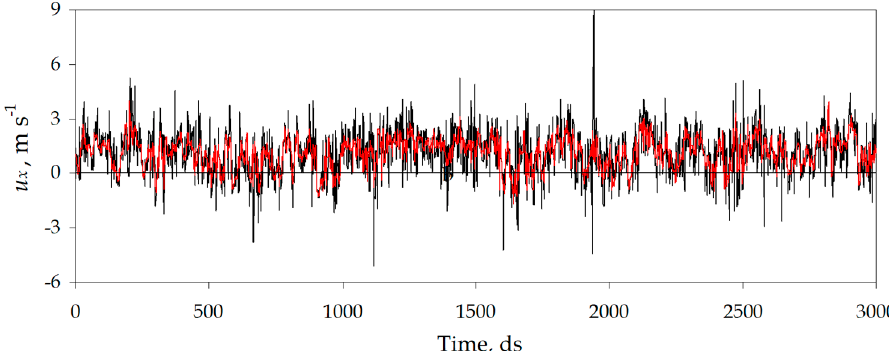
Figure 5. Three-dimensional sonic anemometry u x measurements from Test 1 at the side window windward oriented. Inner side of the IPS at the window ( ▬ ); outer side of the IPS at the window ( ▬ ). Total acquisition time: Five minutes.